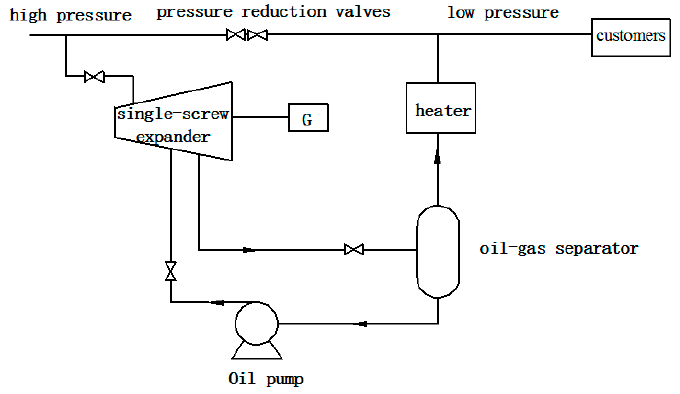
Figure 1. Schematic view of a basic high pressure natural gas pipeline with single-screw expander.